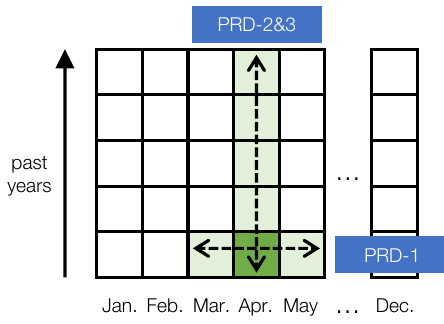
Figure 1. The conceptual diagram of the proposed PRD in case of monthly representation. Each cell indicates a saved representation for the future reference. Type PRD-1 refers adjacent months of the last year, and types PRD-2 and 3 refer the same month of prior consecutive